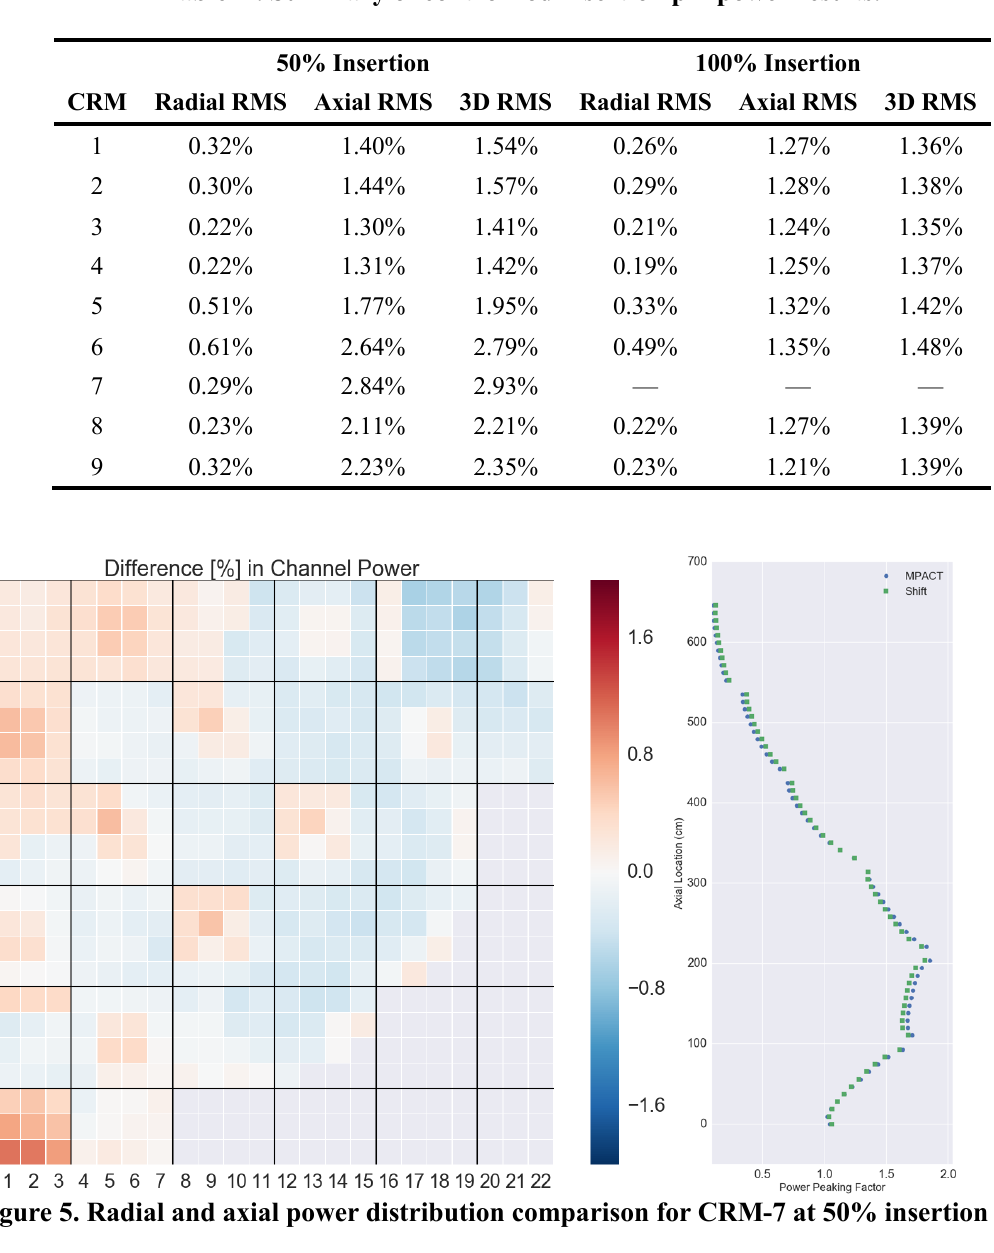
Table II. Summary of control rod insertion pin power results.